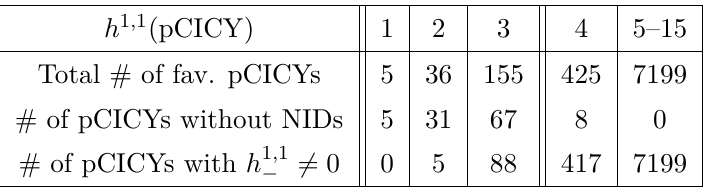
Table 3 . Number of favorable pCICYs without any NIDs which can always result in h 1 , 1 Sr.